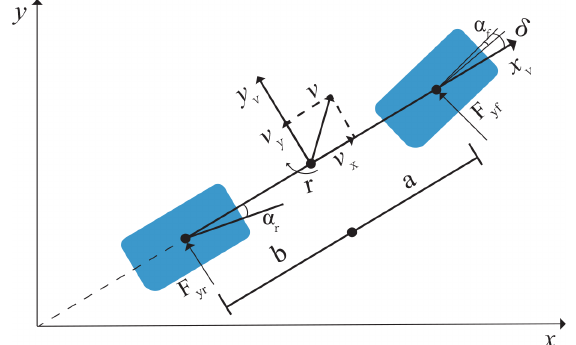
Figure 5. Lateral dynamic model of the bicycle model.